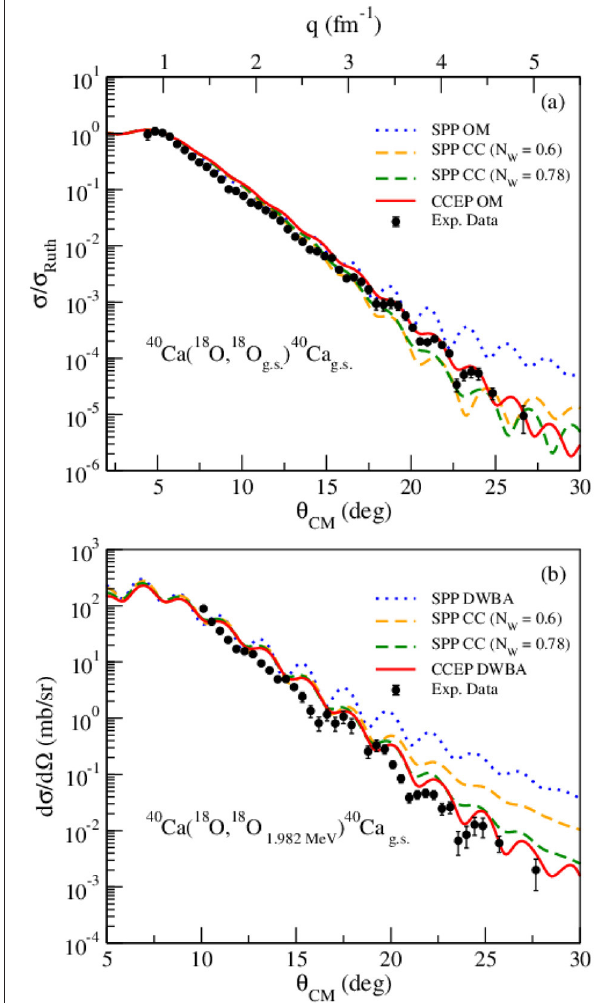
40 Ca elastic + 0.6, the = 0.78, and =